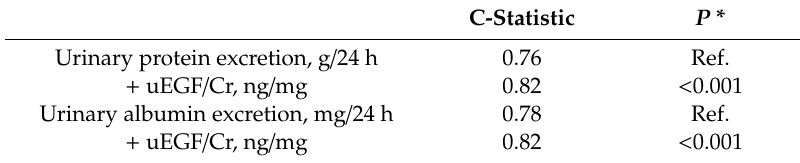
Figure 3. ROC curve of uEGF / Cr for graft failure. During a follow-up of 3 years, 41 (6%) patients developed graft failure. GF, graft failure; uEGF / Cr, urinary epidermal growth factor / creatinine ratio; UAE, urinary albumin excretion; UPE, urinary protein excretion. Urinary protein excretion and urinary albumin excretion had a C-statistic of 0.76 and 0.78, respectively. The predictive value for both variables was significantly improved after the addition of uEGF/Cr (C-statistic = 0.82, F-test for difference among models = P < 0.001) (Table 3). Table 3. Predictive value (C-statistic) for uEGF / Cr on top of established risk factors for graft failure